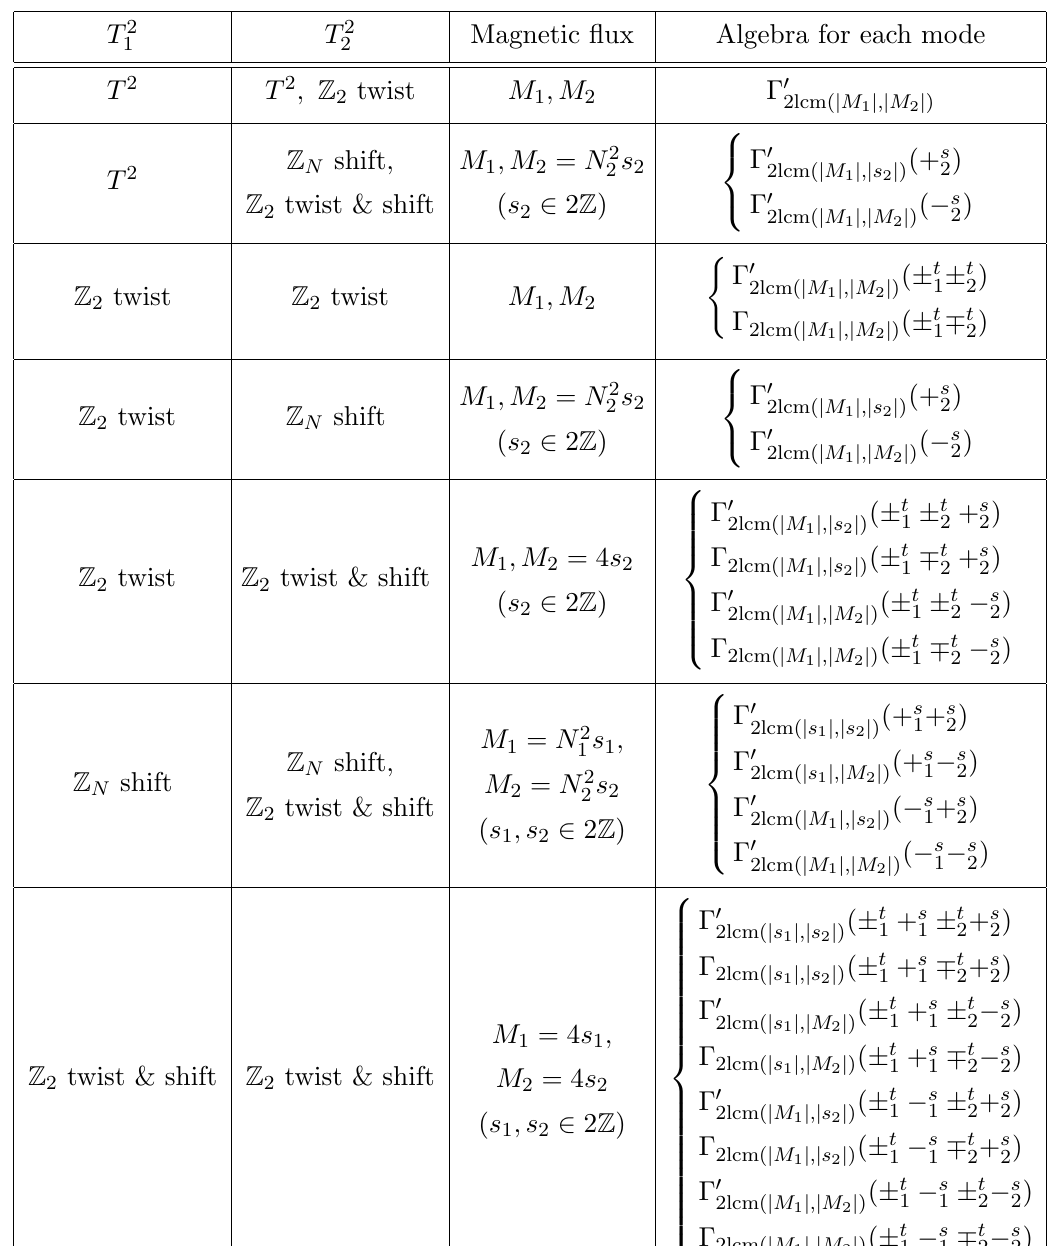
Table 1 . The algebraic relations for the unitary representation on the ( T 2 shift orbifolds. The (cid:12)rst (second) column shows the types of orbifolds from T 2 include T 2 ( T 2 ) itself. The third column shows the (cid:13)ux condition on each orbifold. The last column 1 2 shows the algebraic relations that the unitary representation on the orbifolds at least satis(cid:12)es. The sign (+ = (cid:0) t=s ) means the invariant (+)/variant ( (cid:0) ) modes under the Z 2 twist ( t )/ Z N shift ( s ) on 1 = 2 T 2 ( 1 )/ T 2 ( 2 1 2